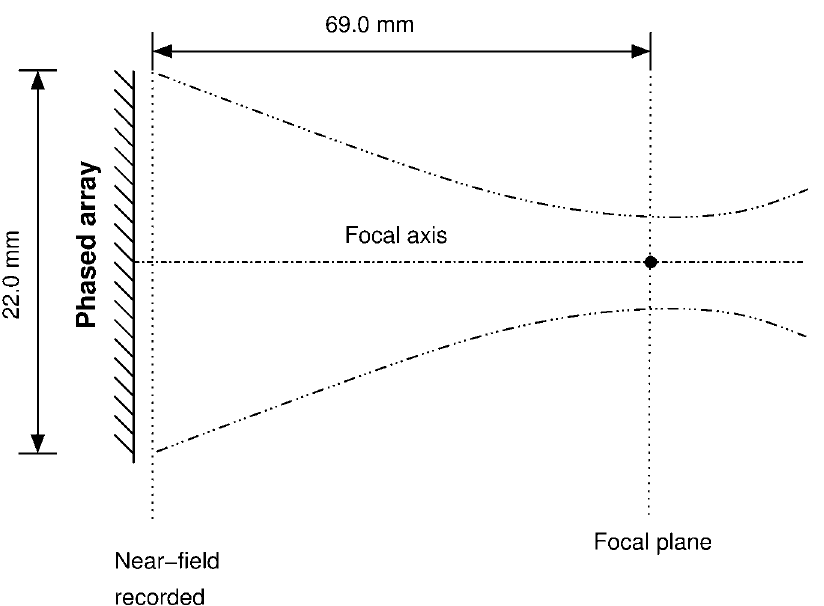
Figure 2. Experimental setup for comparing the KZK-based simulation to hydrophone